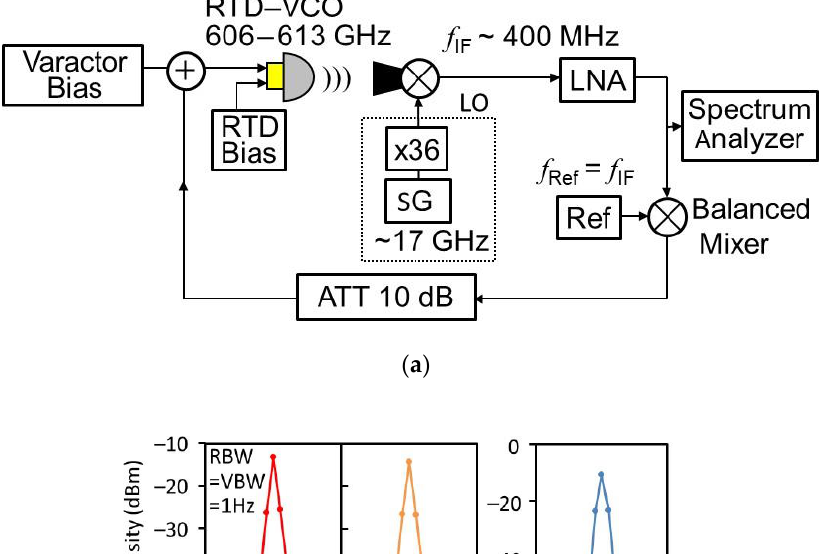
11 of 19 Figure 9. Frequency-tunable RTD oscillator and application to absorbance measurement: ( a ) Array of frequency-tunable oscillators integrated with varactor diodes, and ( b ) absorbance measured by RTD oscillators together with the result of THz time-domain spectroscopy (TDS) measurement. Copyright (2017) The Japan Society of Applied Physics 47]. For the spectral line width, a full width at the half maximum (FWHM) of about 10 MHz has been reported in an RTD oscillator with output power of about 1 μW [89]. The line width is determined by the phase noise caused by the shot noise of the RTD, which is calculated as Δ𝑓 = (𝜋 4⁄ )(𝑝 𝑛 Δ𝑓 𝑟2 𝑃 𝑜𝑢𝑡 ⁄ ) in FWHM [90], where 𝑝 𝑛 is the noise power den- sity per frequency included in the output power 𝑃 𝑜𝑢𝑡 , and Δ𝑓 𝑟 is the line width in FWHM of the resonator system with the RTD capacitance and the slot antenna and without NDC, which is expressed as Δ𝑓 𝑟 = 𝑓 𝑂𝑆𝐶 𝑄⁄ , using the oscillation frequency 𝑓 𝑂𝑆𝐶 and the Q factor of this resonator system. From this equation, the line width can be reduced by an increase in the product 𝑃 𝑜𝑢𝑡 𝑄 2 . Spectral narrowing with high Q factor by an RTD efficiently cou- pled to a photonic-crystal cavity has been reported [91].